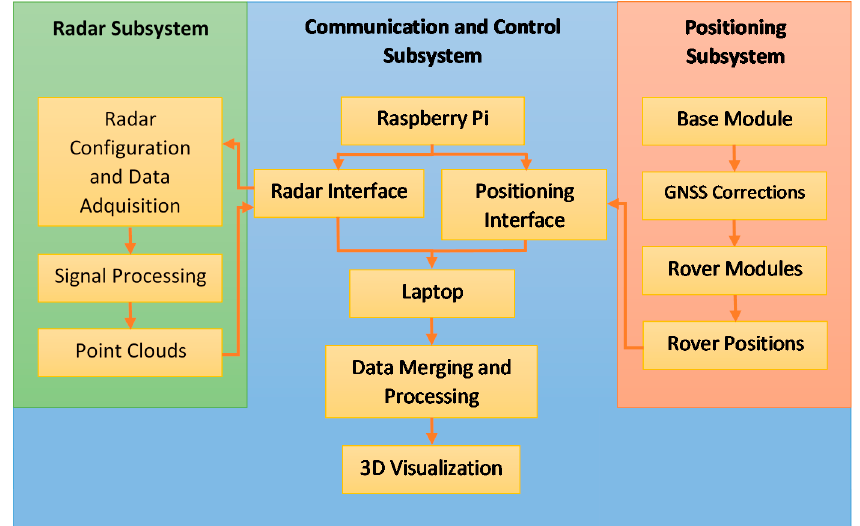
Figure 2. Workflow of the proposed system.